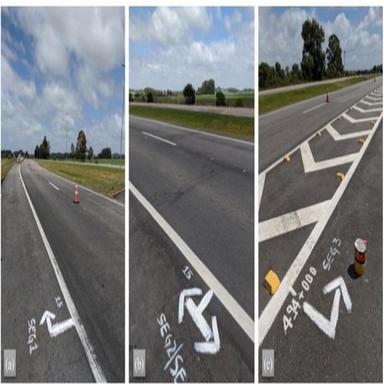
Experimental sites: (a) Site 01; (b) Site 02; (c) Site 03.